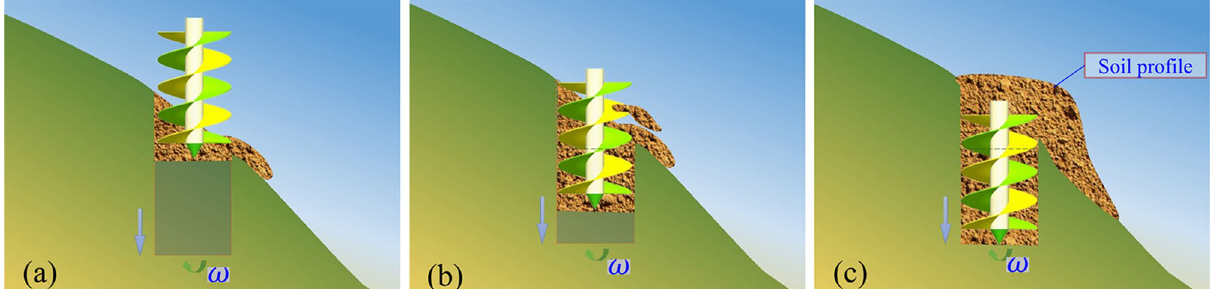
Figure 3. Diagram of dig process. ( a ) The first process. ( b ) The second process. ( c ) The third process.